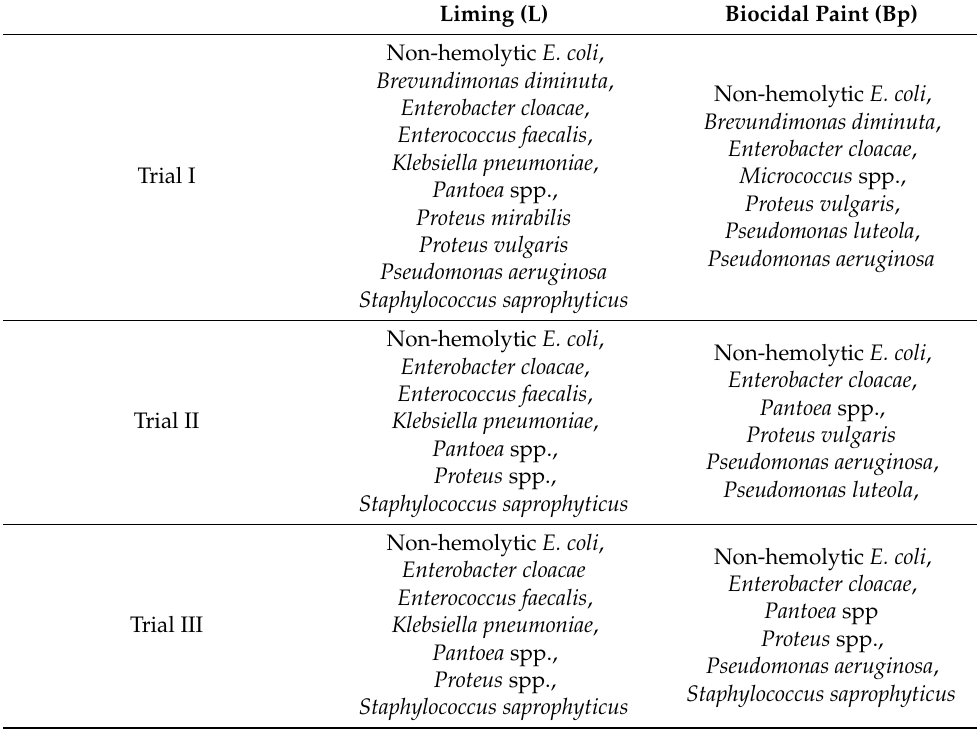
Table 7. Bacterial genera/species identified in the air.